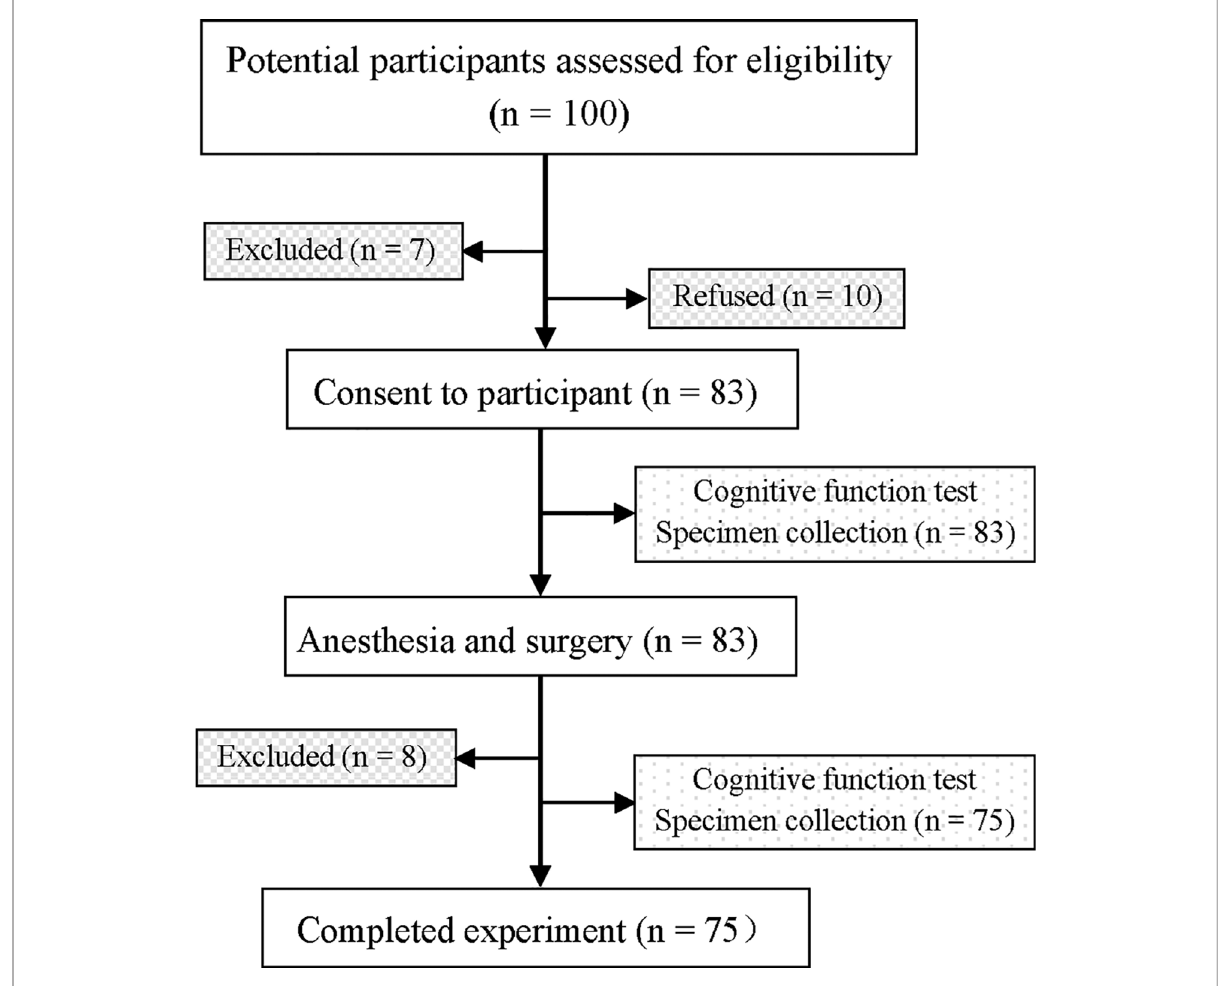
FIGURE 1 Flow chart of the study. overall, 100 patients were recruited, and 75 patients completed all the